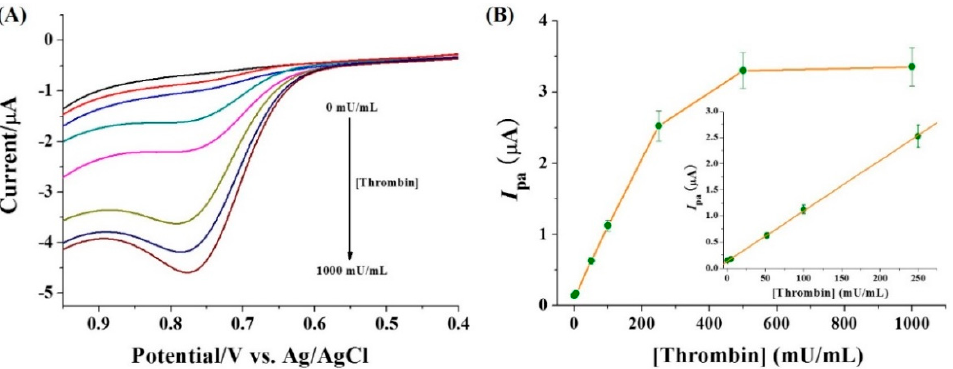
Figure 4. ( A ) DPVs for the detection of different concentrations of ACE (0, 1, 5, 10, 25, 50, 100 and 200 mU/mL) and ( B ) calibration plots for the detection of ACE in the range of 1~50 mU/mL. The concentrations of substrate and Cu(II) were 50 μ M.